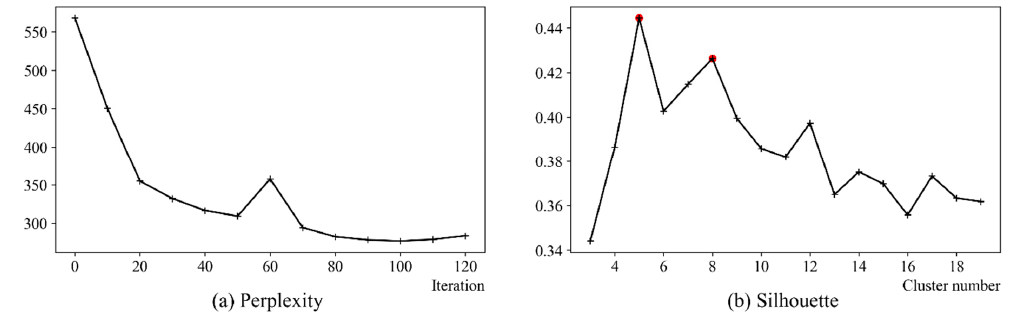
Figure 5. The change of perplexity value in the topic modelling process ( a ) and the choice of different cluster numbers in the clustering process ( b ).